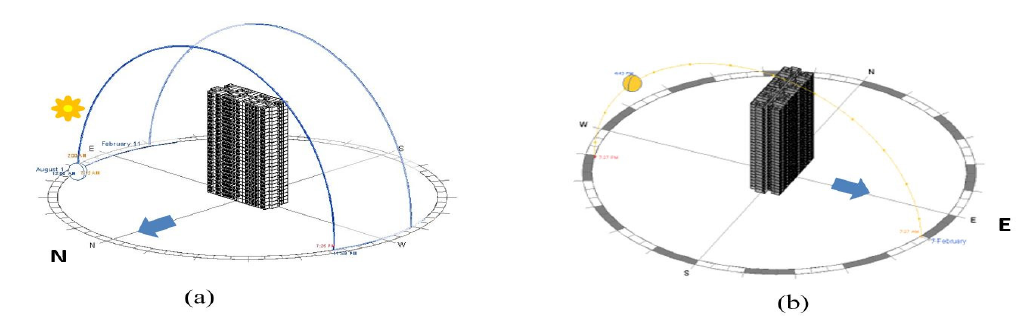
Figure 5. Building Orientation: ( a ) Case 1 Base Model—Building front facing North (0° Orientation); ( b ) Case 2 Building front facing East (90° Orientation).